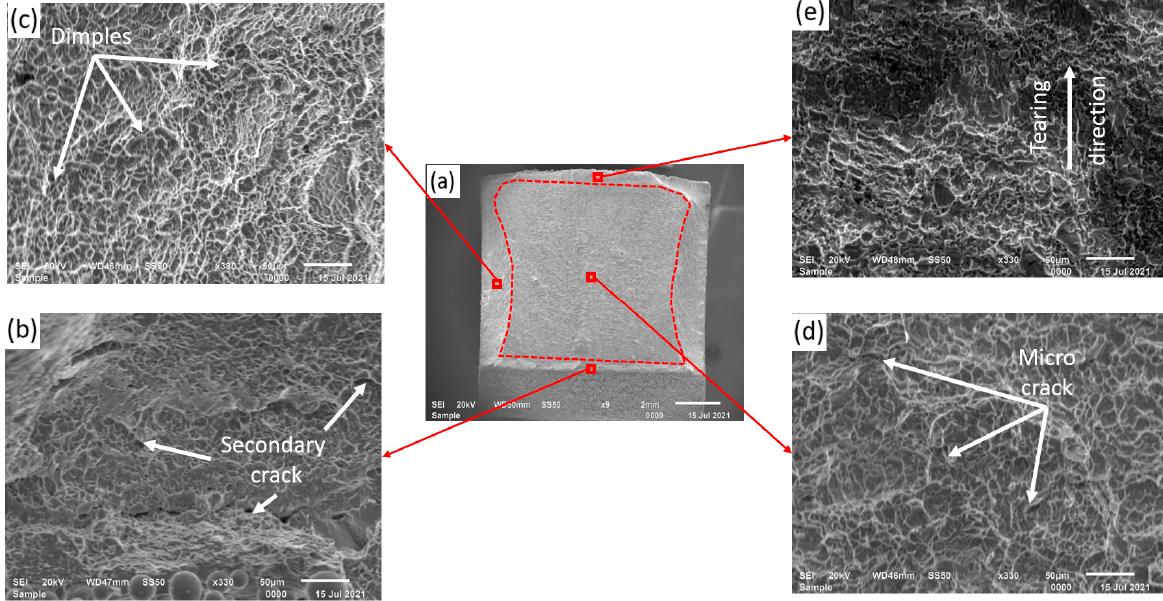
Figure 6. ( a ) SEM SE images of the fracture surface of a Z specimen with 3D-printed V-notch, ( b ) crack initiation zone, ( c ) shear-lip region ( d ) unstable fracture, and ( e ) final fracture.